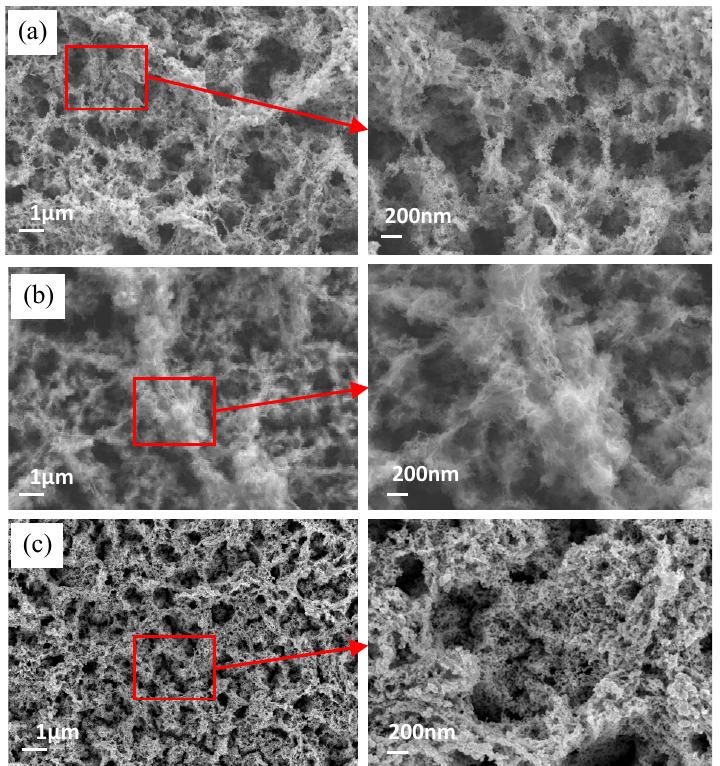
Figure 4. SEM images of the surface after dealloying for different times: ( a ) 5 min; ( b ) 10 min; ( c ) 30 min.